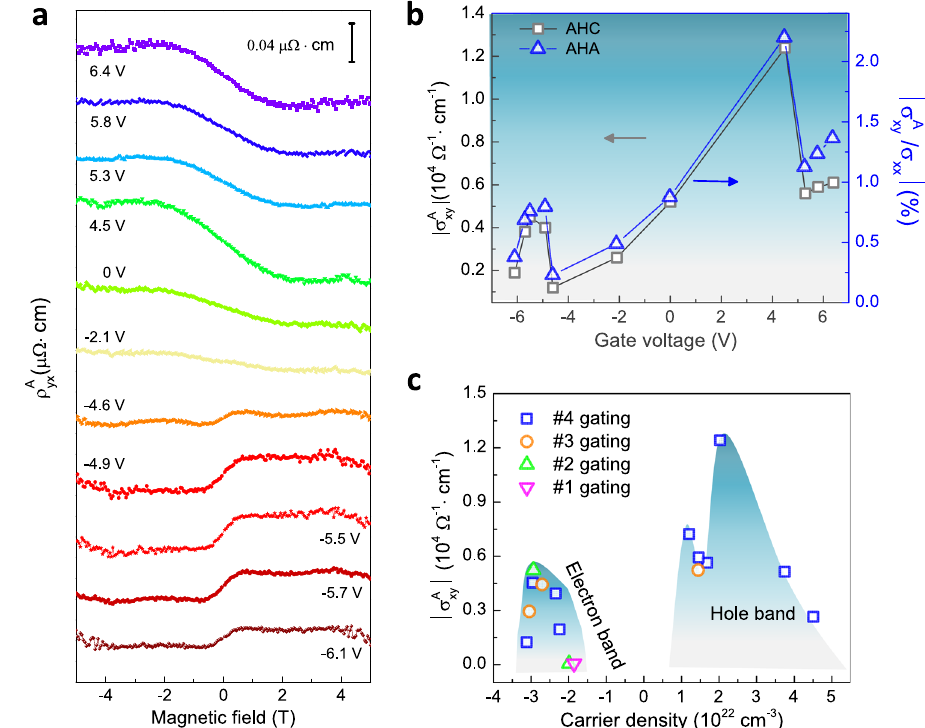
Fig. 3 | Gate-tuned giant anomalous Hall effects in device #4.a Gate-dependent anomalous Hall effect at 5K after subtraction of the linear Hall background in the high fi eld regions (ordinary Hall part). b Gate-dependent AHC and anomalous Hall